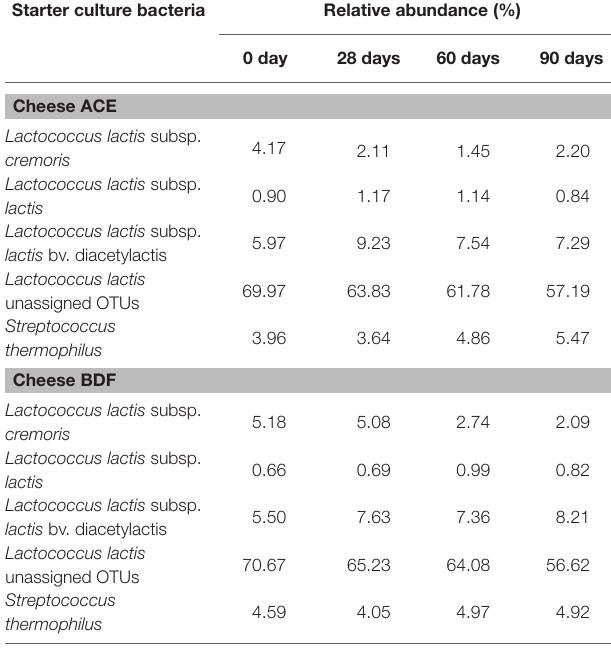
TABLE 4 | Average relative abundances of starter culture bacteria during 10 ° C ripening of Gouda cheese manufactured with unpasteurized milk (cheeses ACE) or with unpasteurized milk inoculated with 1 log CFU/ml of Listeria monocytogenes (cheese BDF). Starter culture